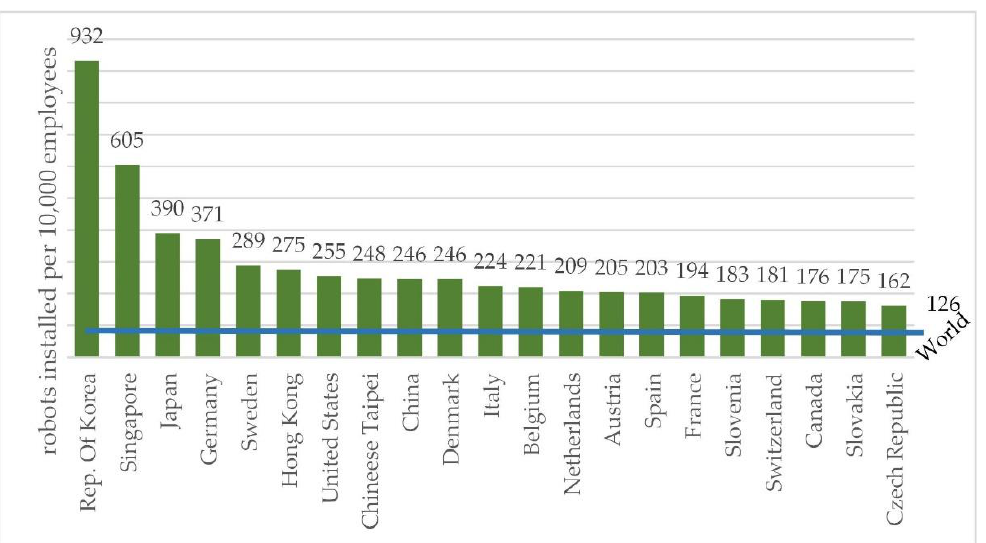
Figure 3. Robot density in the manufacturing industry 2020 [2].